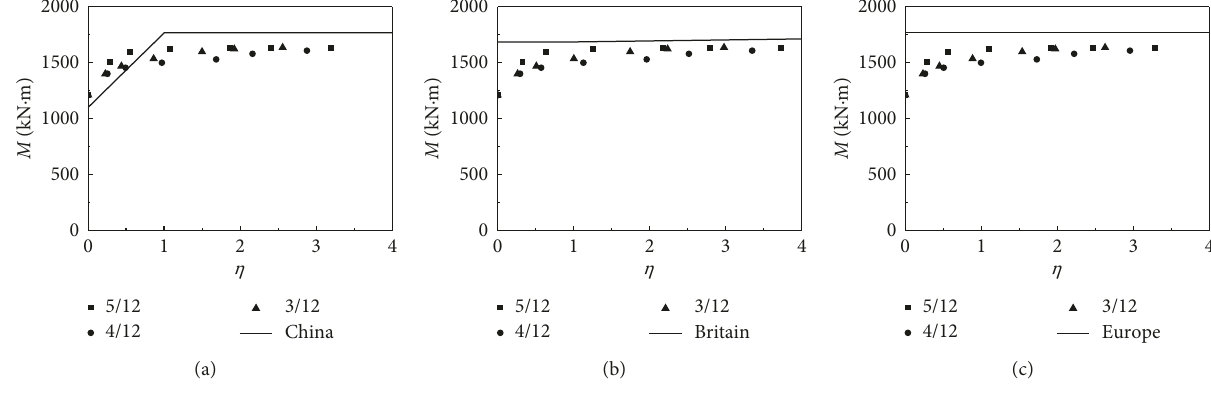
Figure 16: Influences of the loading position and manner on M - ç relationship: comparison between the results of (a) GB 50017 and FEA, (b) BS 5950 and FEA, and (c) Eurocode 4 and FEA.